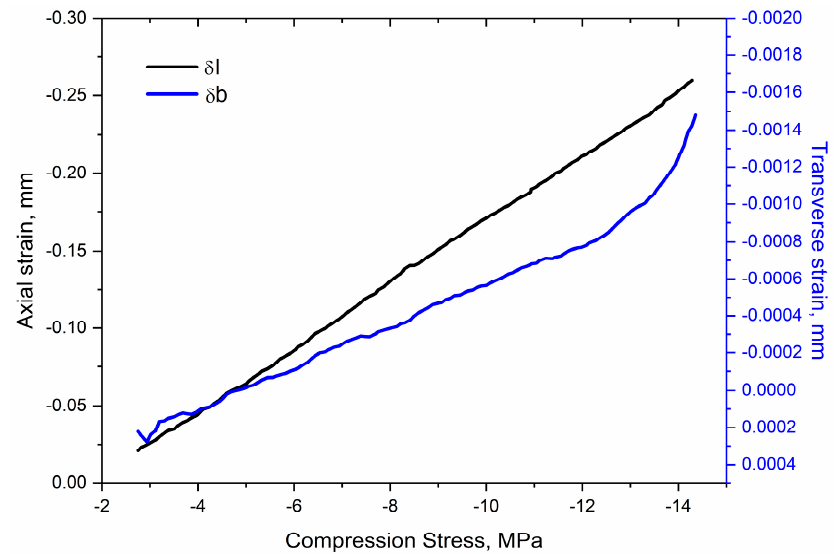
Figure 11. A variation in length and width of the lattice structure ( δ l and δ b) during compression.